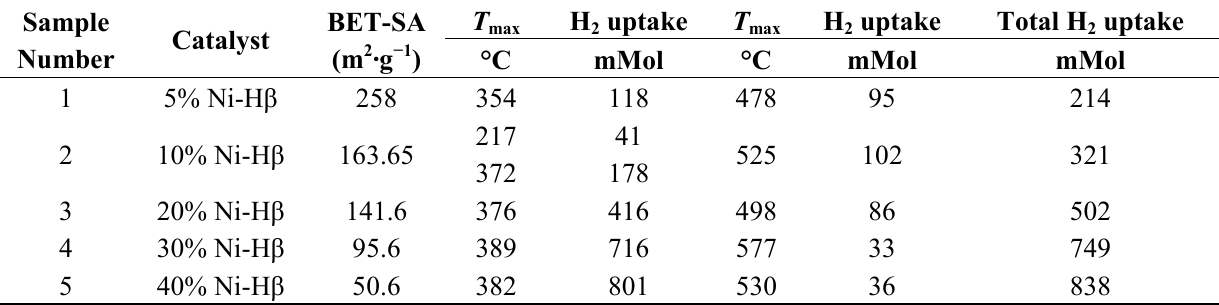
Table 1. Physicochemical property of Ni/H β -zeolite